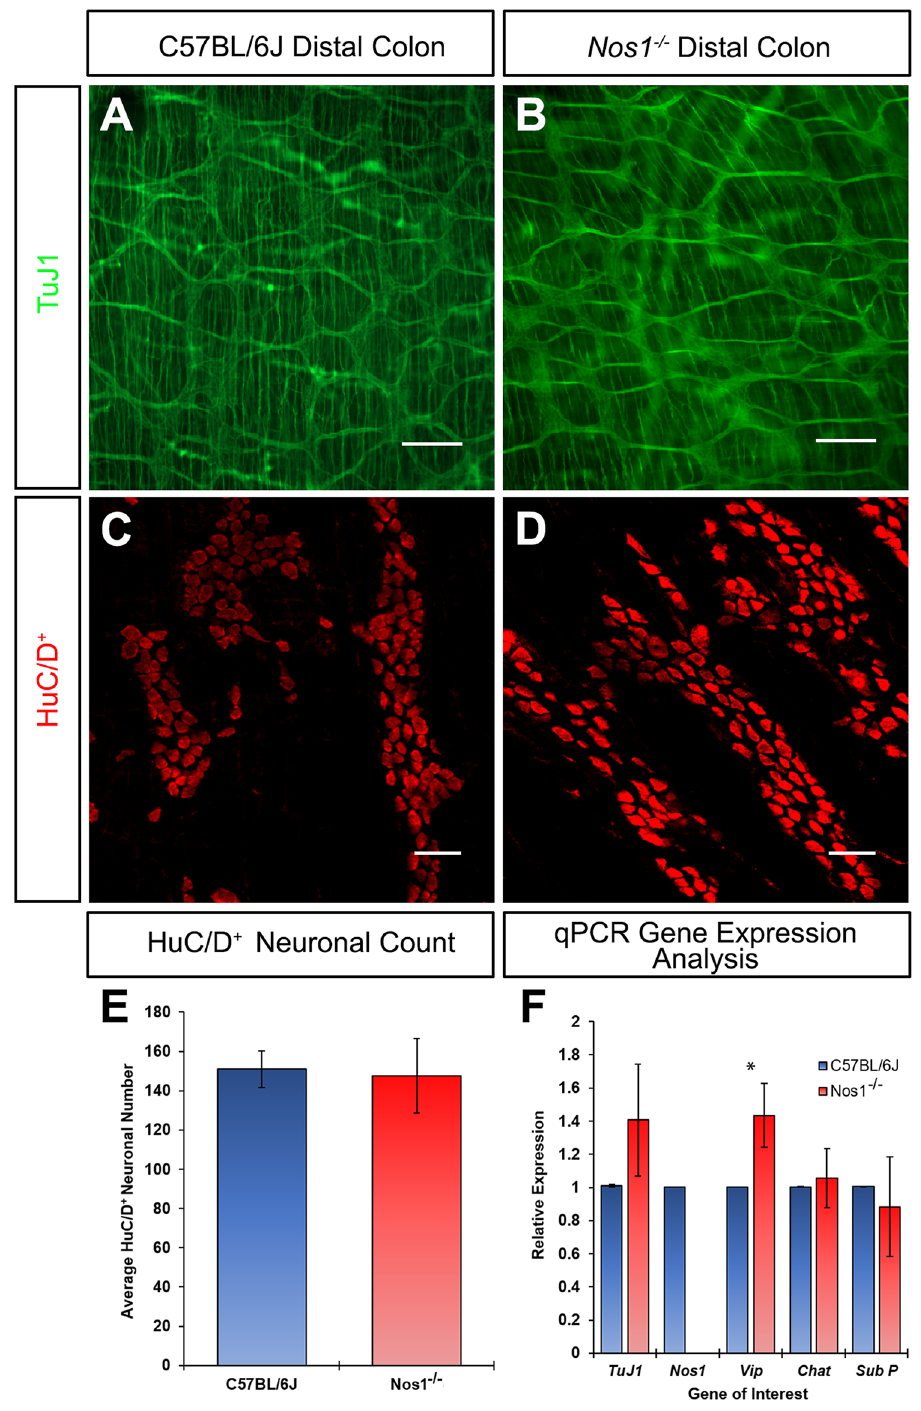
Figure 2. The ENS in Nos1 −/− distal colon is visually comparable to C57BL/6J mice but displays transcriptional compensation. ( a , b ) Representative montages of stitched low-power images showing the TuJ1 + (green) ENS in the C57BL/6J ( a ) and Nos1 −/− ( b ) distal colon. ( c , d ) Representative high-power confocal image showing HuC/D + (red) neuronal cell bodies, at the level of the myenteric plexus, in the C57BL/6J ( c ) and Nos1 −/− ( d ) distal colon. ( e ) Summary data of HuC/D + neuronal cell counts in the C57BL/6J (blue bar, 25hpf, n = 5) and Nos1 −/− (red bar, 25hpf, n = 5) distal colon. P > 0.05 by Student’s t-test. ( f ) Gene expression analysis in C57BL/6J (blue bars, n = 3) and Nos1 −/− (red bar, n = 3) distal colon showing mRNA fold change (ΔΔCT) of major excitatory and inhibitory neuronal subtypes. Error bars represent mean ± s.e.m. in all panels. * P ≤ 0.05 comparing ΔCT values by Welch’s t-test. Scale bars, 200 μm ( a , b ) 50 μm ( c , d